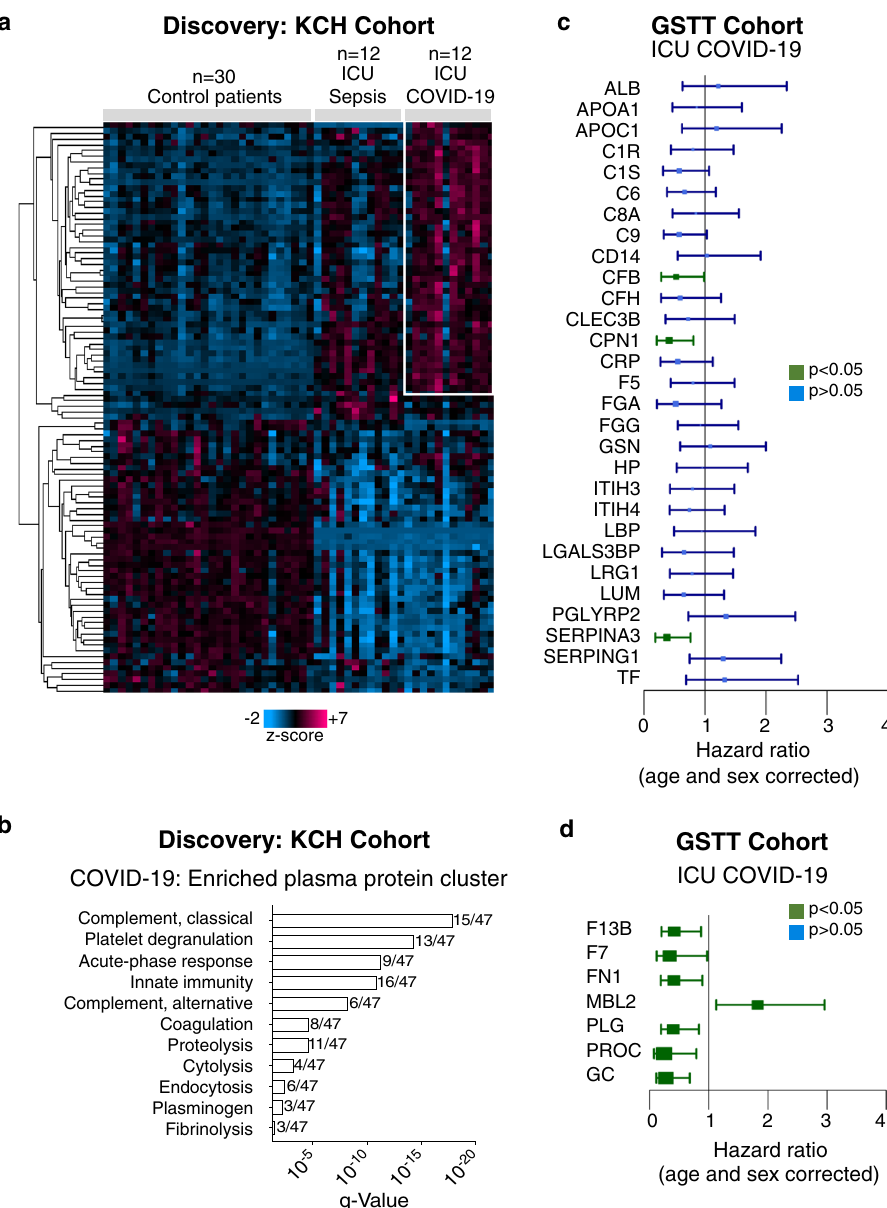
Fig. 3 COVID-19 circulating proteome signature and associations with 28-day mortality. a Plasma proteome pro fi ling was conducted using a data- independent acquisition – mass spectrometry (DIA-MS) approach with spiked standards for 500 proteins. Hierarchical cluster analysis was conducted upon signi fi cantly changing plasma proteins across control patients before elective cardiac surgery ( n = 30), ICU patients with sepsis ( n = 12), and ICU patients with COVID-19 ( n = 12, KCH). The heatmap highlights 47 proteins enriched in COVID-19. Kruskal – Wallis, Benjamini – Hochberg correction q < 0.05. b Gene ontology enrichment analysis was conducted upon these 47 proteins and signi fi cantly enriched pathways are represented. c Twenty-nine common proteins cross-referenced against two published proteomic studies, exploring protein markers of COVID-19 severity. The ability of these 29 proteins to predict 28-day mortality was explored in an independent ICU patient cohort ( n = 62 patients, GSTT) by DIA – MS, and hazard ratios with 95% CI are shown. d Proteomic analysis by DIA-MS conducted upon the serum samples of the GSTT COVID-19 ICU cohort returned additional candidates that predict 28-day mortality as shown on hazard ratio plots with 95% CI ( n = 62 patients, GSTT). Signi fi cance was determined through the Mann – Whitney U test, correcting for age and sex and applying the Benjamini-Hochberg procedure. All statistical analyses are and Vero cells were transfected with an LGALS3BP-coding plas- siNT1 (Fig. 8b – d). Strikingly, LGALS3BP overexpression also sig- mid, followed by transfection of a SARS-CoV-2 spike-coding ni fi cantly reduced cell – cell fusion compared with pcDNA3 and plasmid 24 h later. Small interfering RNA (siRNA)-mediated pmCherry. This reduction in cell-cell fusion was dose-dependent knockdown of ACE2 served as a positive control (siACE2), while with increasing amounts of LGALS3BP plasmid (Supplementary transfection of siNT1 (non-targeting control siRNA), pcDNA3 Fig. 12a – c). To rule out an effect of LGALS3BP on green fl uor- (plasmid backbone) and pmCherry (plasmid coding for mCherry) escent protein (GFP) expression, we co-transfected a GFP-coding served as negative controls (Fig. 8a). As expected, siACE2 signi fi - plasmid demonstrating that the LGALS3BP-coding plasmid had no cantly reduced spike-mediated cell-cell fusion compared with effect (Supplementary Fig. 12d, e). Overexpression of LGALS3BP